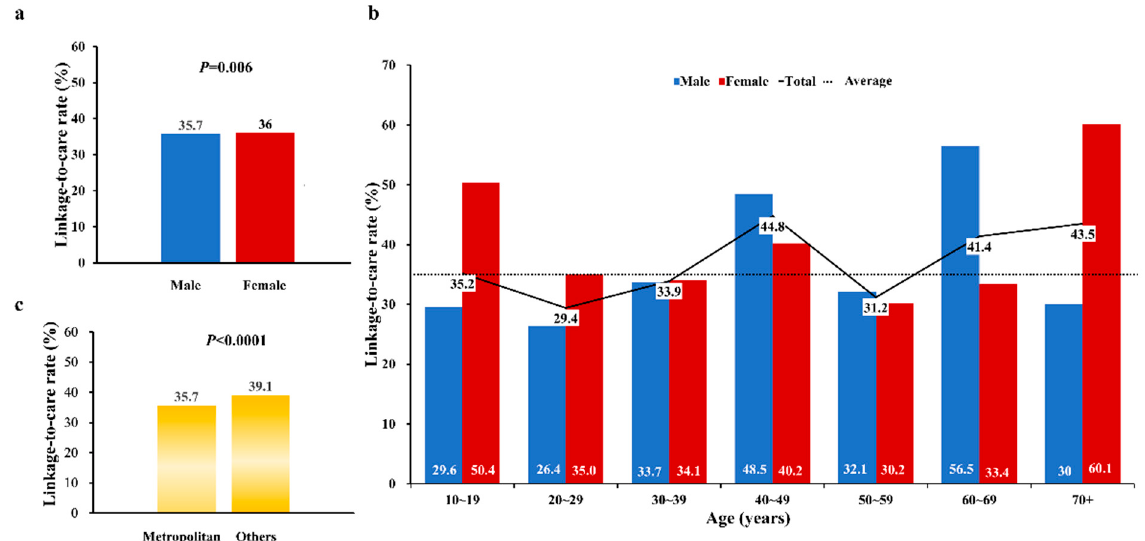
Figure 2. Estimated LTC rates of CHB patients between 2002 and 2006 according to ( a ) sex, ( b ) age groups, and ( c ) regions.